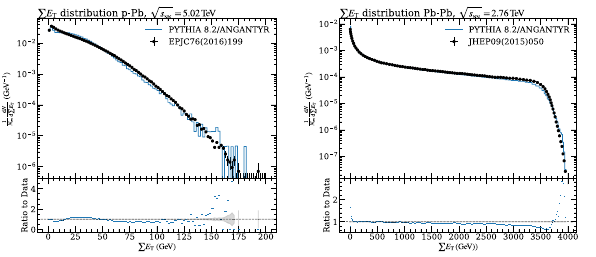
Fig. 8 Centrality measure by Atlas for p–Pb at [40] (left) and Pb–Pb at Pythia